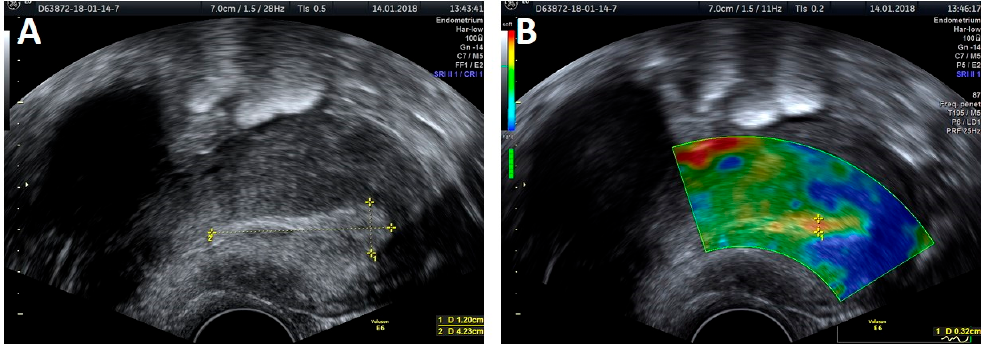
Figure 1. A 2D ultrasound presentation: endometrial thickness ( A ) and elastography: thickness measurement of the softest layer of the endometrium ( B ).